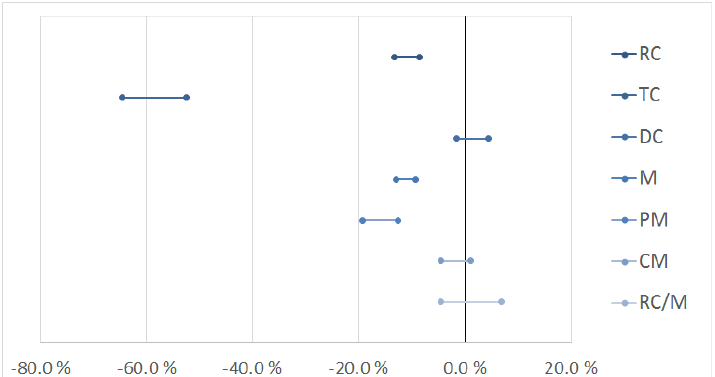
Figure 6. Ninety-five percent confidence intervals of the difference in real costs, hours of maintenance performed, real costs per hour maintenance performed and vessel capacity for Fleet 1 and Fleet 2. Positive differences mean that the values of Fleet 2 are greater than for Fleet